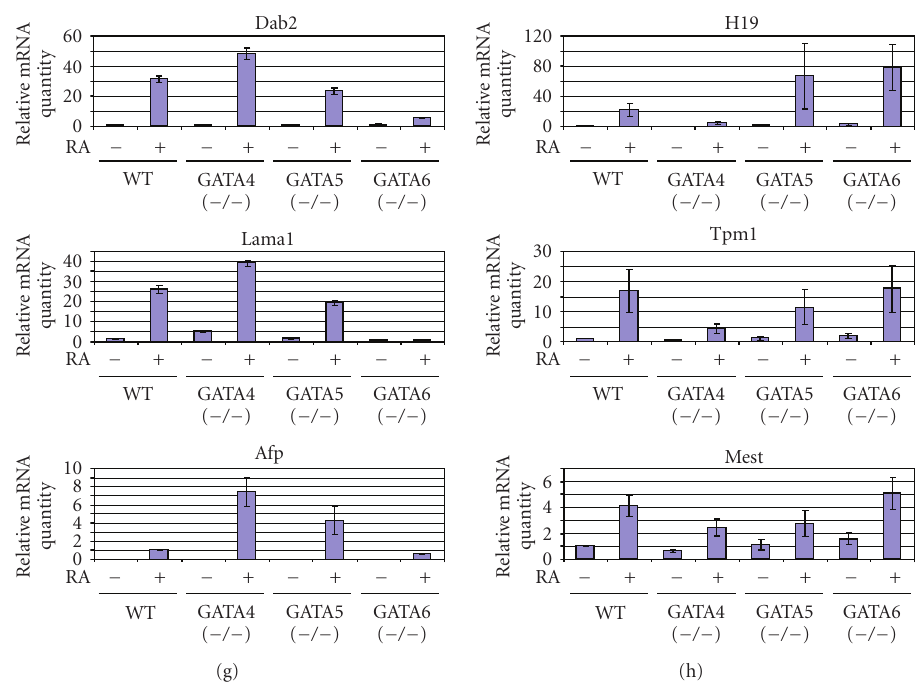
Figure 5: Expression array analysis and verification by quantitative RT-PCR of retinoic acid-induced endoderm di ff erentiation of GATA- deficient ES cells. Wild type embryonic stem cells and those homozygous deficient in GATA4, GATA5, or GATA6 were cultured as monolayers and treated with the DMSO carrier as a control or retinoic acid (1 μ M) for 4 days. (a) Representative morphology of the cells with or without retinoic acid. (b) The cells were analyzed by cDNA expression microarray comparing with or without retinoic acid. The results were analyzed by hierarchical clustering. Individual colored rows represent change in expression following retinoic acid treatment of a single gene/sequence tag. Red rows indicate an increase in expression and green rows indicate a decrease in expression, as shown by the color scale bar. (c)–(h) Verification of expression of a panel of selected genes by quantitative RT-PCR Relative gene expression changes with or without retinoic acid in monolayer cells (c) and spheroids (d) are presented as “Heat-Maps”. The figure displays grey scale shades representing the Ct values. Ct (cycle threshold) is the number of PCR cycles at which the fluorescence reaches a significant level above the baseline, given that the higher the starting copy number of the nucleic acid target, the sooner fluorescence increases. The relative levels of a particular transcript between samples can be calculated using the equation: relative quantity = 2 − (cid:2) Ct. The amplification of TBP shows similar amounts of template in all samples. (e)–(h) values that represented relative mRNA levels of the monolayer ES cells are shown and compared. The mRNA values of undi ff erentiated ES cells are defined as “1” for comparison. The detection of a real-time RT-PCR signal in a specific GATA transcript in the ES cells that were homozygous knockout of that GATA gene is likely due to the presence of transcripts from the mutant/inactive GATA